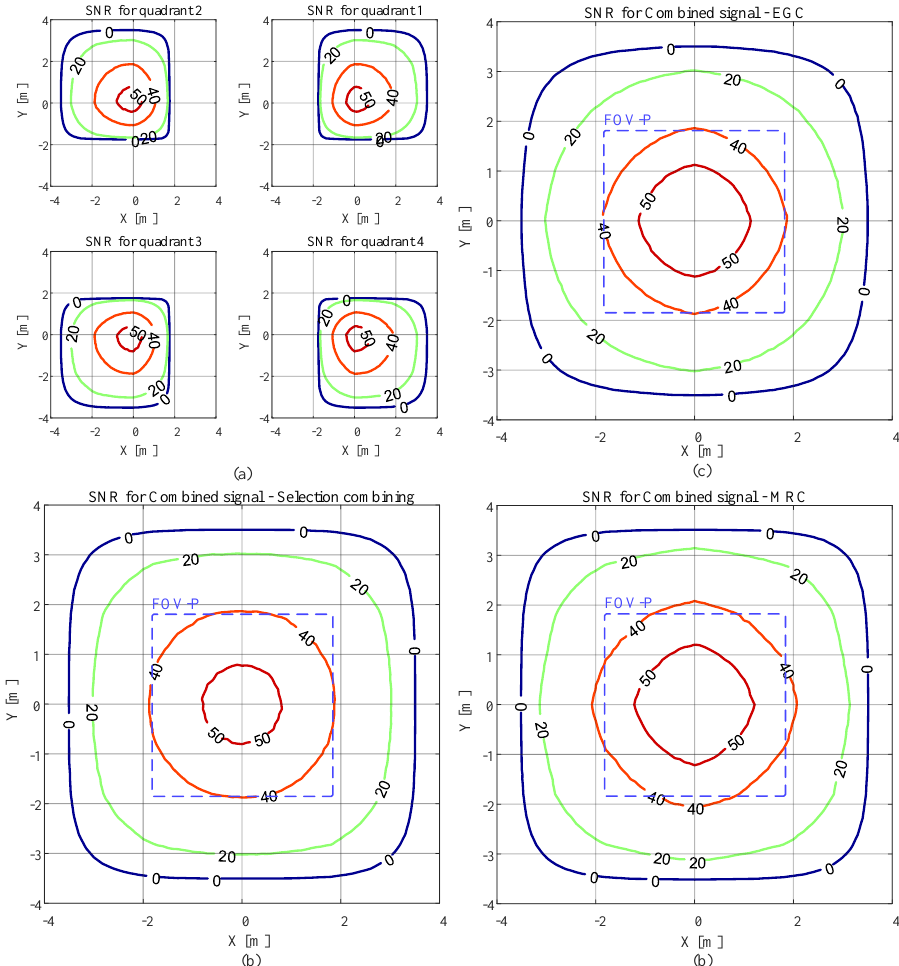
Figure 7. SNR in dB versus QADA location in an area equipped with a single transmitter with m = 1 and with the receiver parallel to the plane on which the luminaire is located with a FOV-C of 63.4 ◦ for ( a ) each quadrant, ( b ) the combined signal using selection combining, ( c ) the combined signal using EGC, (d) the combined signal using